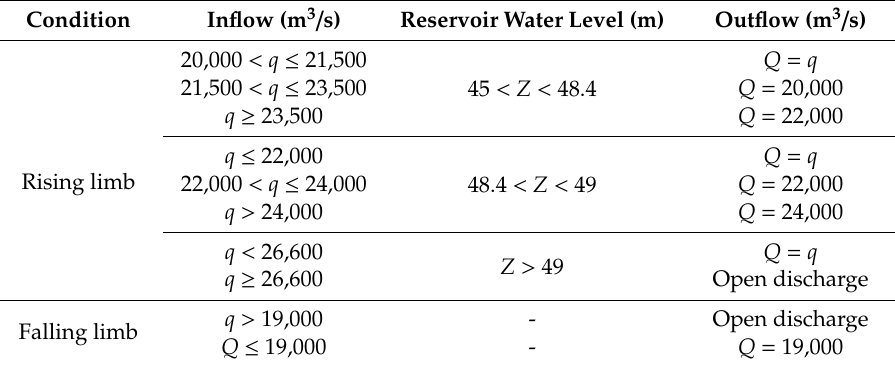
Table 4. Conventional flood control operation of the Xiajiang